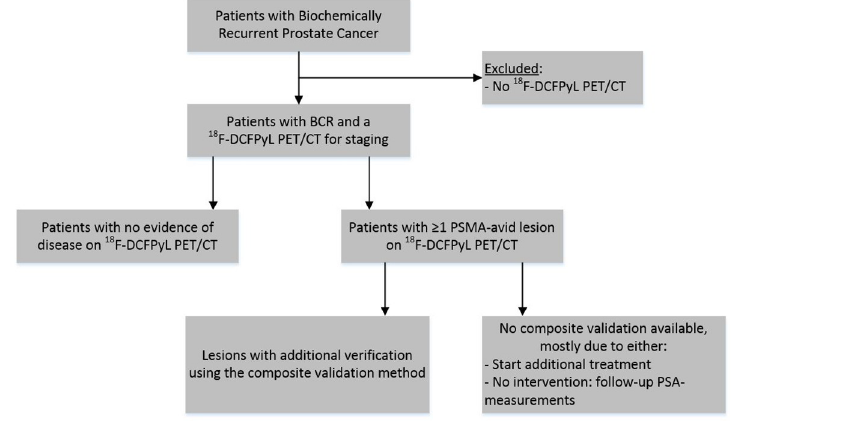
Fig 1. STARD flowchart of the included